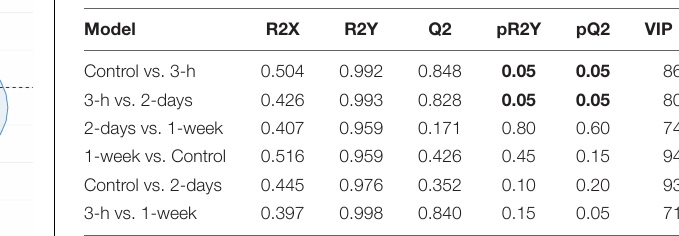
TABLE 3 | Supervised multivariate PLS-DA models computed from metabolites found in CSF metabolome differentiating two groups.